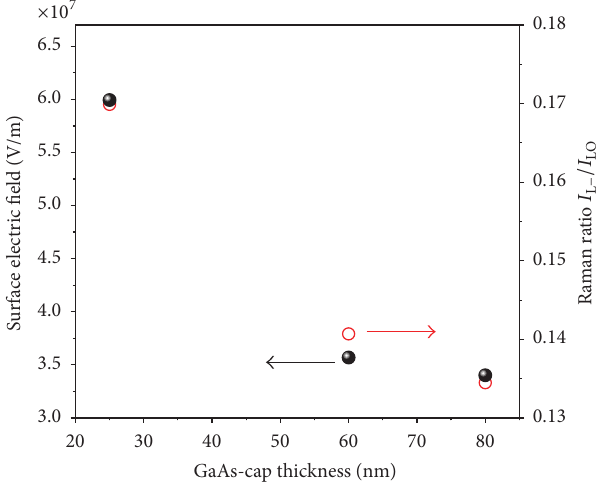
Figure 6: Behavior comparison of the surface electric field obtained by PR (black point) and Raman ratio 𝐼 function of cap layer